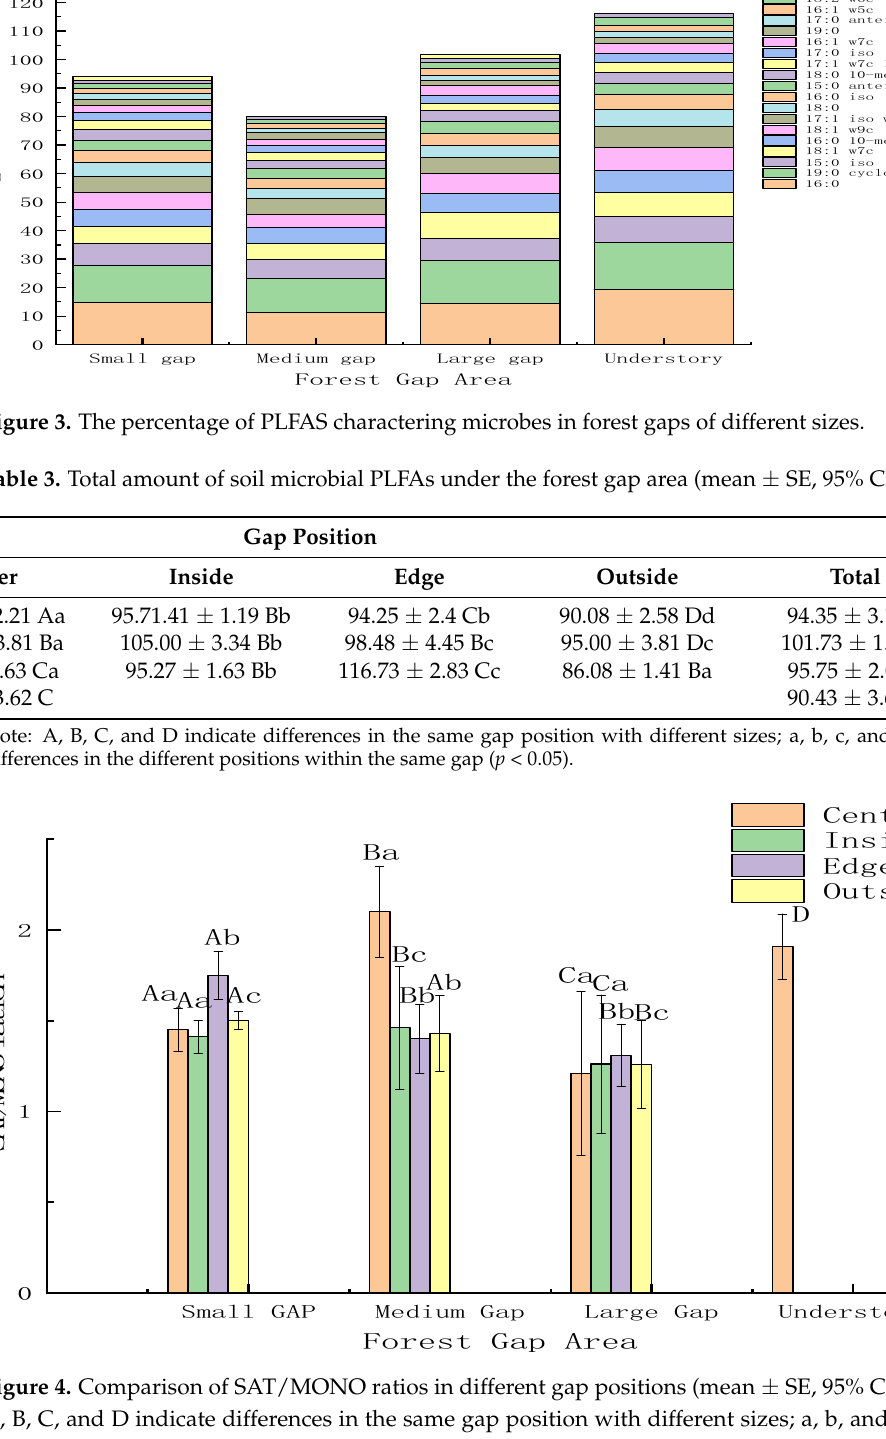
Figure 4. Comparison of SAT/MONO ratios in different gap positions (mean ± SE, 95% CI). Note: A, B, C, and D indicate differences in the same gap position with different sizes; a, b, and c show differences in different positions within the same gap ( p < 0.05).